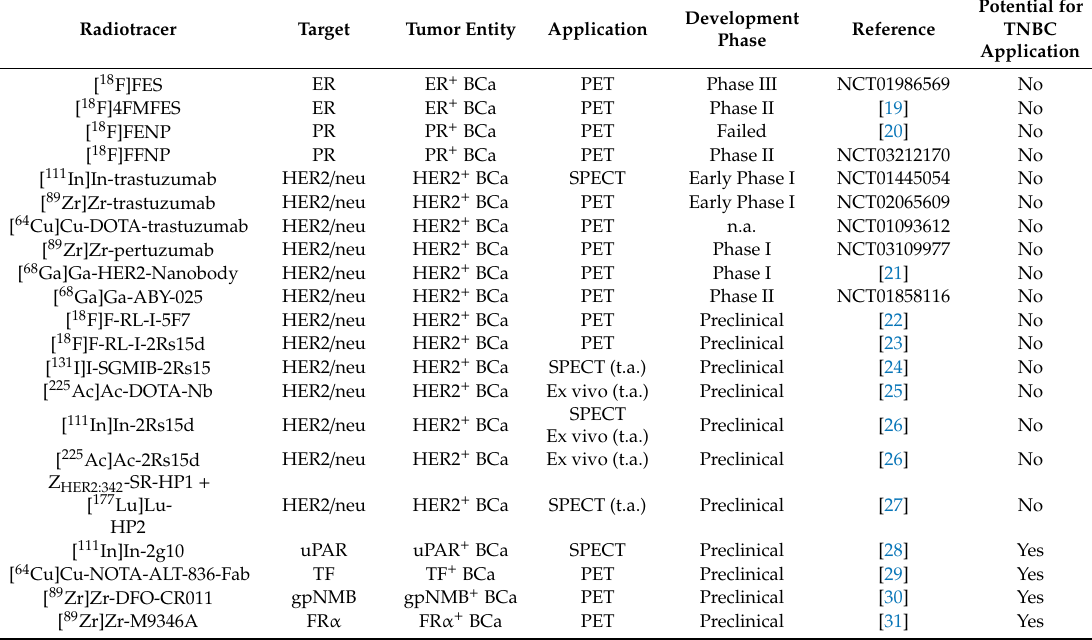
Table 1. Current radiotracers in preclinical or clinical applications in order of appearance. T.a. = therapeutic